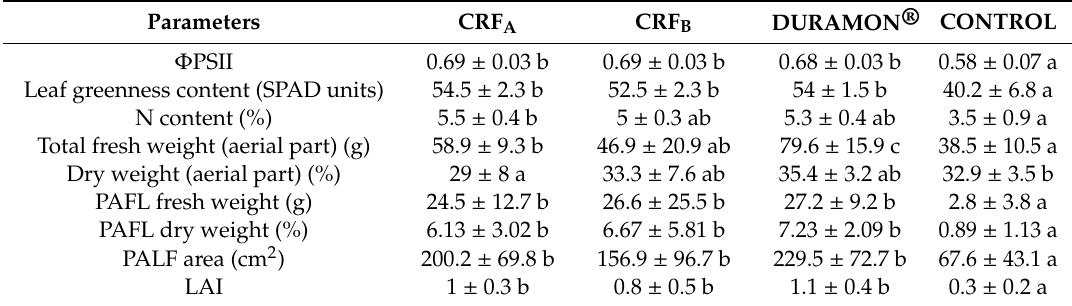
Table 2. E ff ects of fertilizer treatments CRF A , CRF B, and DURAMON ® on photosynthetic parameters (e ff ective quantum yield of photosystem II— Φ PSII, leaf greenness, nitrogen content, total fresh weight of aerial parts (g), dry weight of aerial parts (%), photosynthetically active flag leaves—PAFL fresh weight, PAFL area, and leaf area index—LAI) in Triticum aestivum leaves compared to the Control in the phenological state of panicles swelling (booting state). Values are means ± SD ( n = 18 for Φ PSII, leaf greenness, and N content; n = 8 for the other growth parameters).